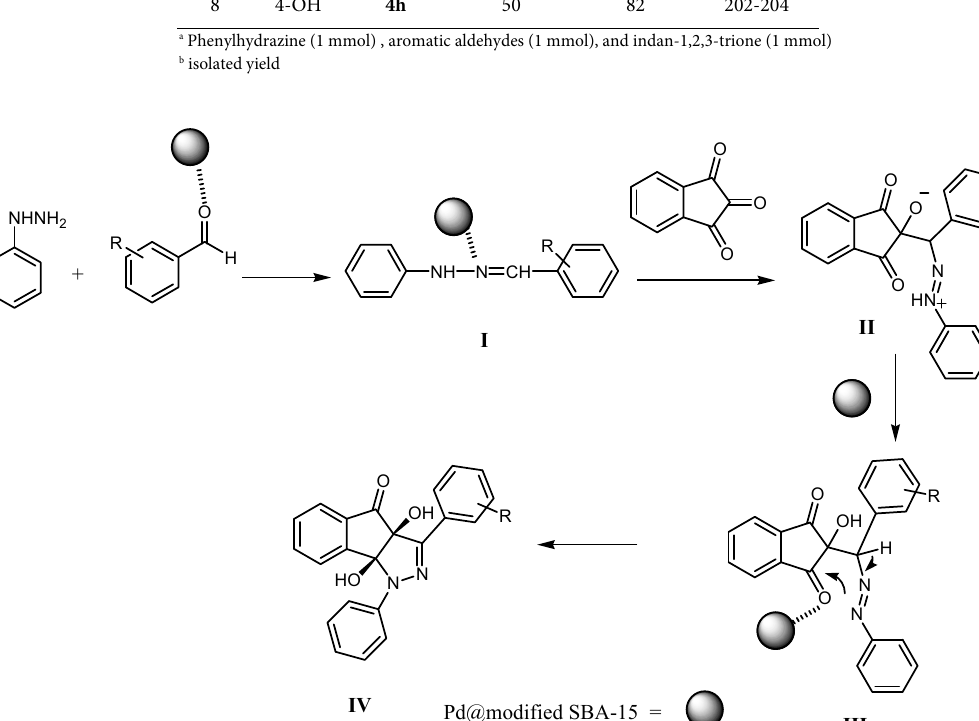
Scheme 3 . Proposed mechanism for the synthesis of indenopyrazolones